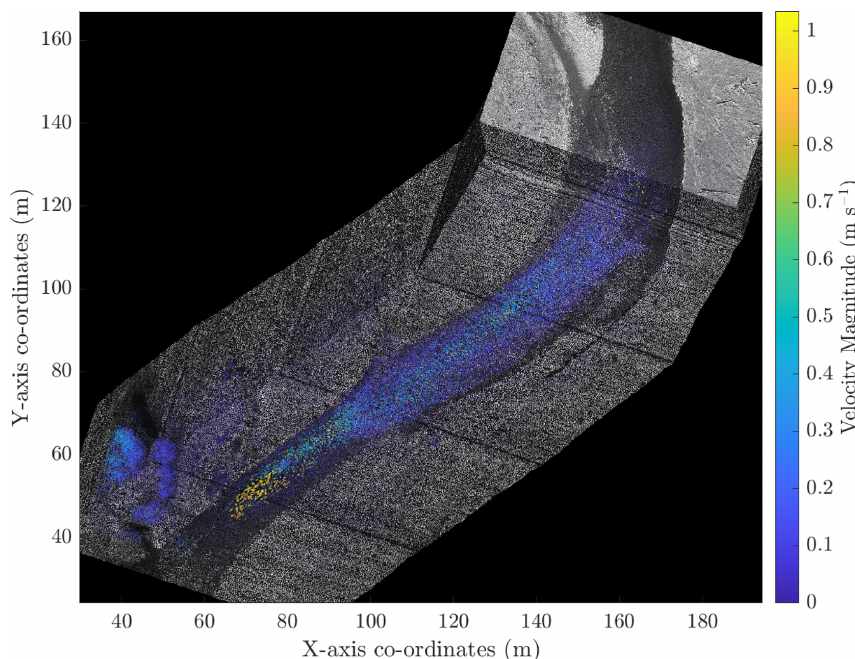
Figure 7. KLT-IV v1.0 outputs illustrating the apparent velocities of features within the river corridor of the river Coquet (UK) following analysis using differential GPS and IMU data to orthorectify the imagery prior to stabilisation and image velocimetry